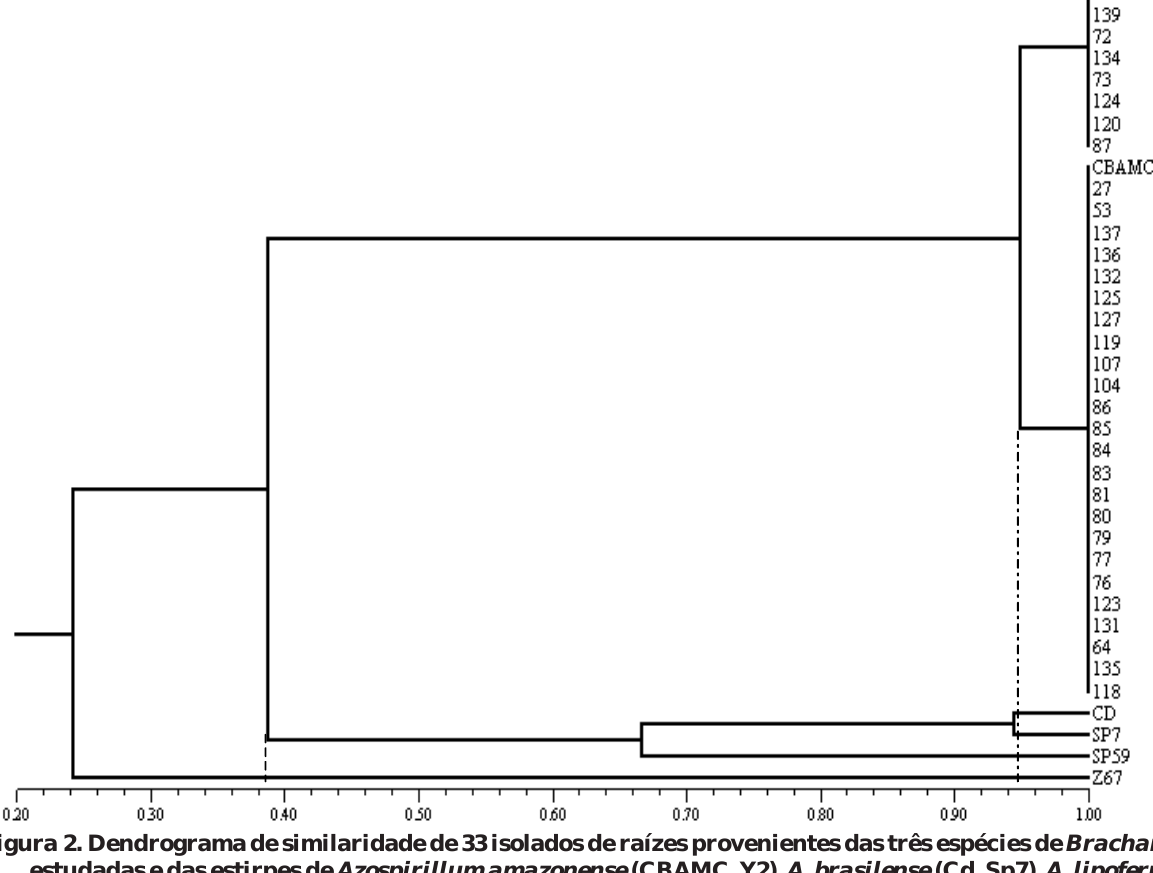
Figura 2. Dendrograma de similaridade de 33 isolados de raízes provenientes das três espécies de Bracharia estudadas e das estirpes de Azospirillum amazonense (CBAMC, Y2), A. brasilense (Cd, Sp7), A. lipoferum (Sp59) e Herbaspirillum seropedicae